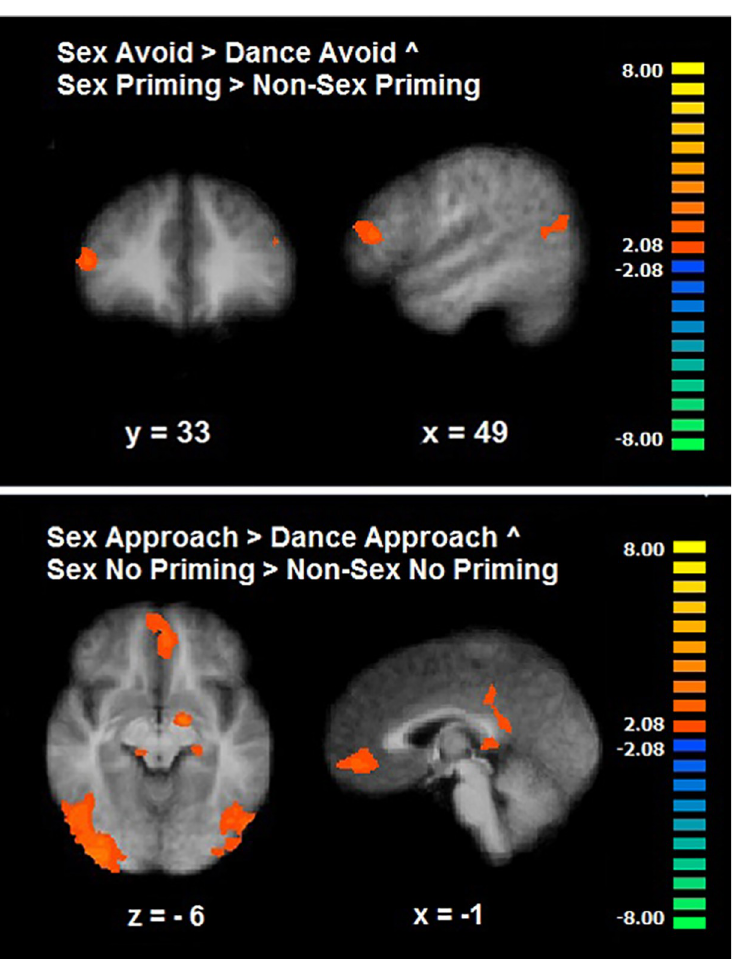
Fig 8. Conjunction of motivational and cognitive sexual inhibition. Common brain activation during the two sexual inhibitory conditions (up: Sex Avoid and Sex Priming) and during the two sexual non-inhibitory conditions (down: Sex Approach and Sex No Priming) (CLTC, p <